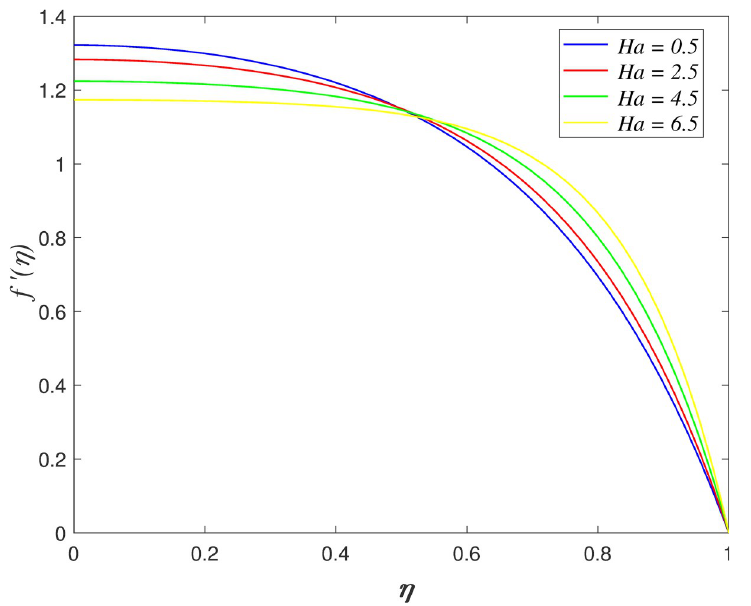
Fig 11. Impact of Ha on axial